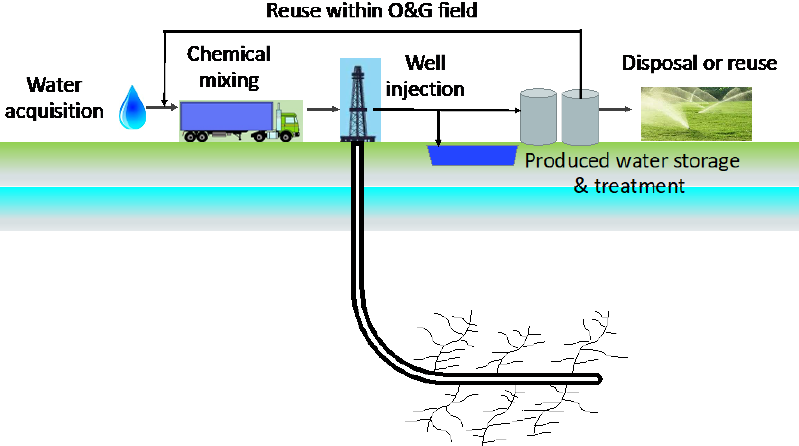
Figure 1. Schematic diagram of produced water management and reuse.